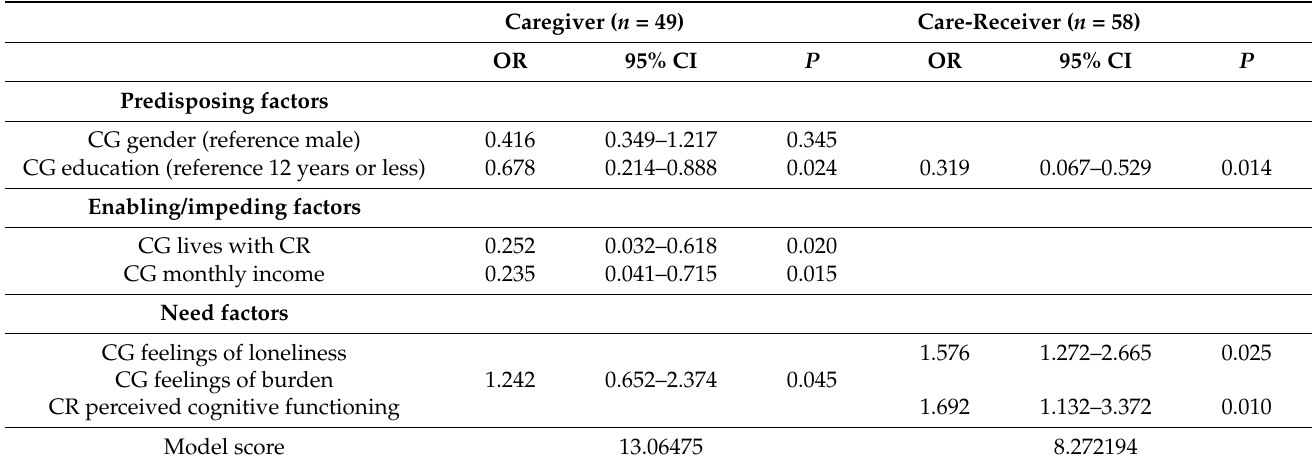
Table 4. Exact logistic regression model for forgone care for caregivers (CG) and care-receivers (CR). Caregiver ( n =